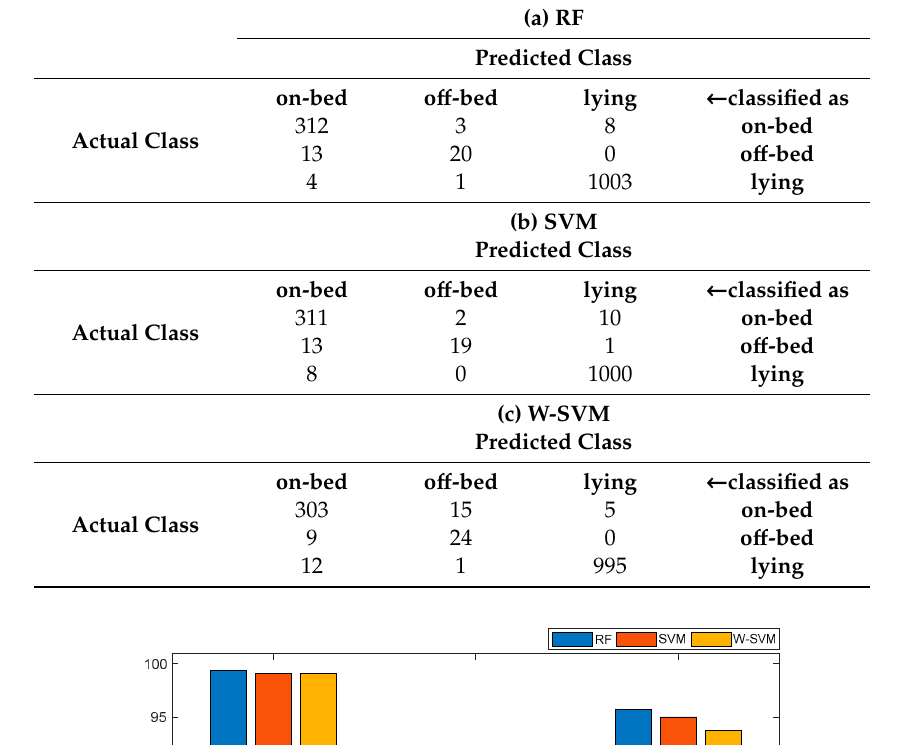
Table 7. RFID results using di ff erent classification algorithms ( a ) Random Forest, ( b ) SVM, ( c ) W-SVM.